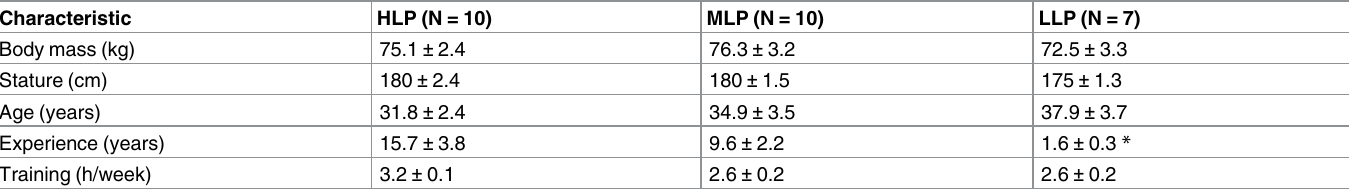
Table 2. Swimmers’ characteristics (data are means ±